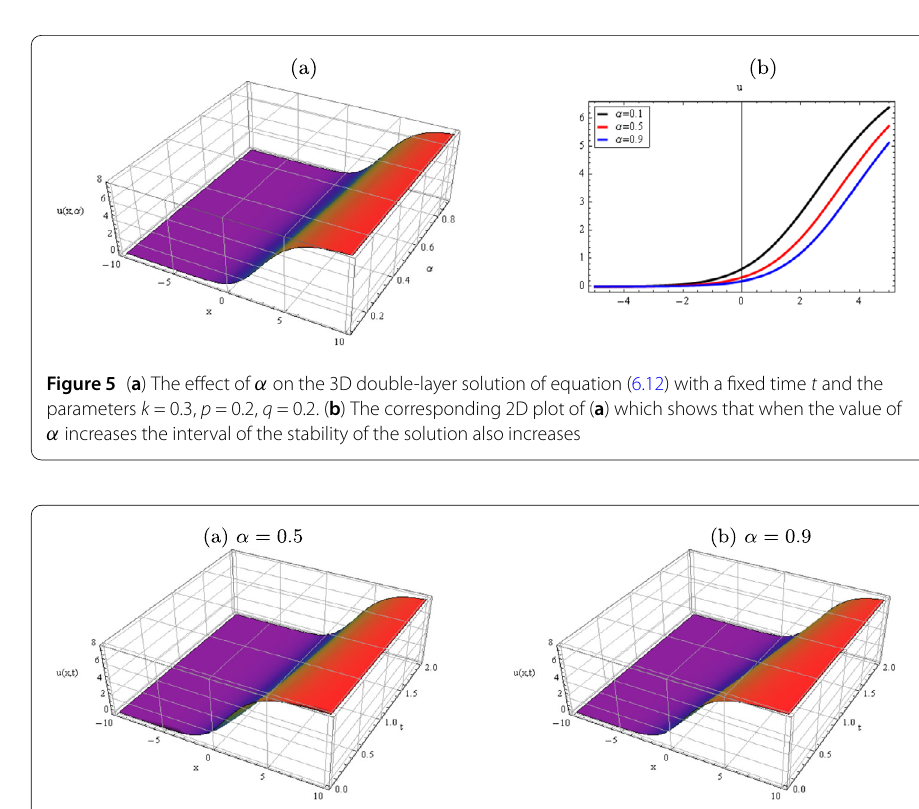
Figure 6 The 3D double-layer solution of equation (6.12) at different values of α = 0.5,0.9 with the suitable parameters k = 0.3, p = 0.2, q =